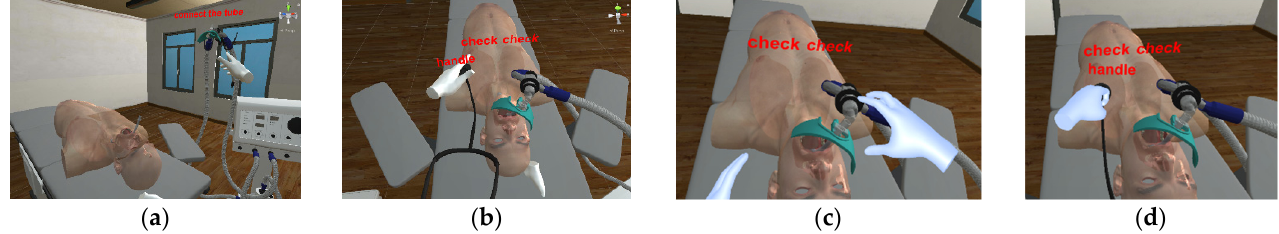
Figure 6. The scene of ventilation machine connection and verification: ( a ) connection with controller; ( b ) verification with controller; ( c ) connection with hand; ( d ) verification with hand.